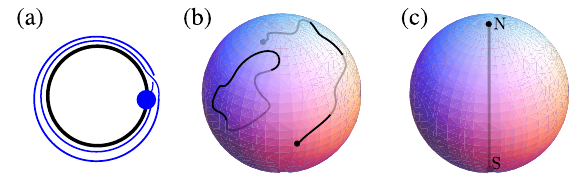
ffiffiffi p Q Q þ k ¼ ð 1 ; (cid:1) 1 = Þ and , with Q 3 1 1 2 2 1